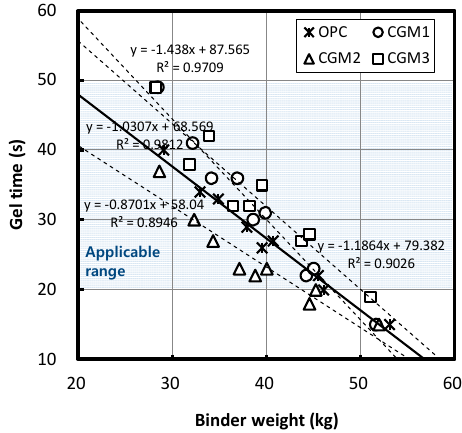
Figure 8. Gel time by binder weight.